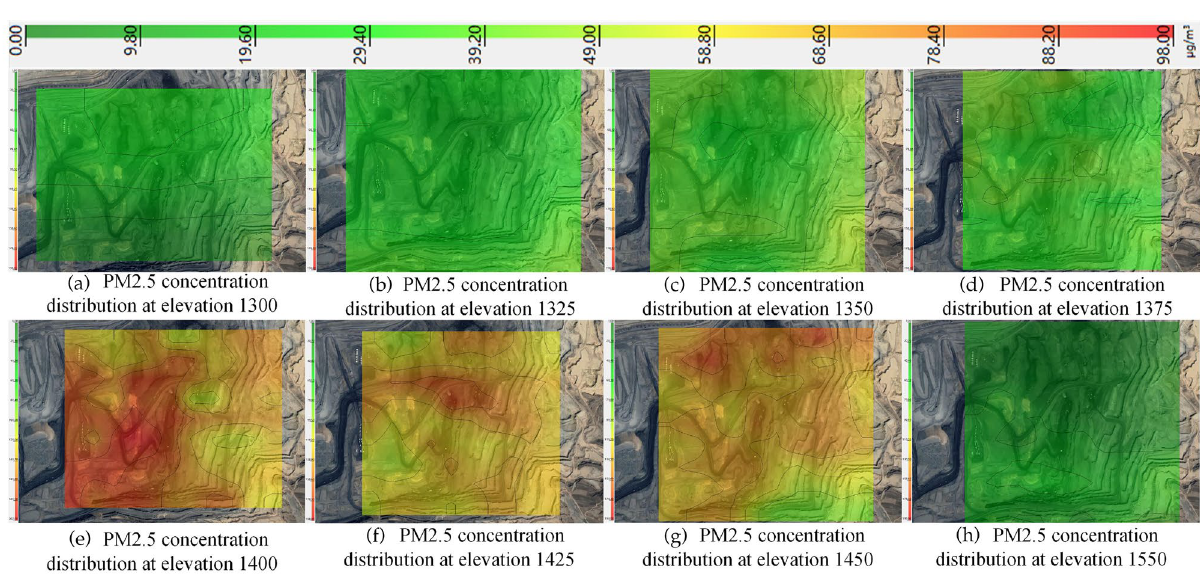
Figure 10. PM2.5 distribution from 1300 to 1550 elevation in